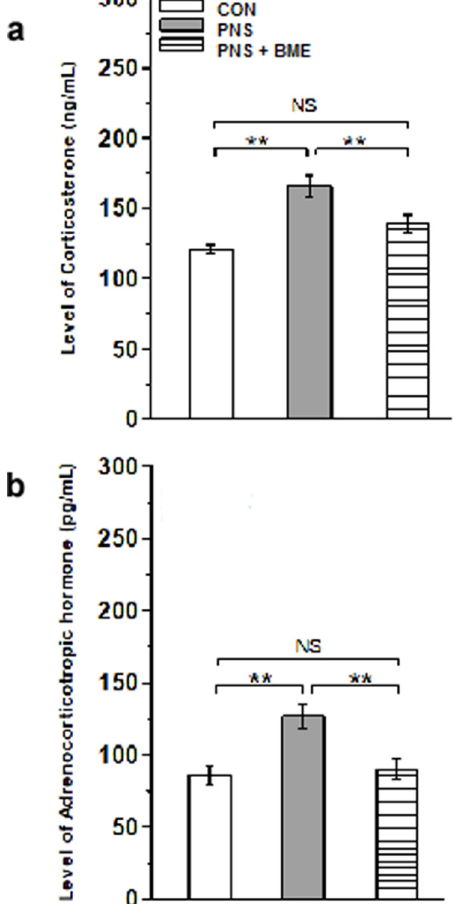
Figure 4. Maternal exposure to BME treatment and the resilience effect on the PNS-induced changes in offspring plasma. ( a ) Corticosterone (CORT); ( b ) Adrenocorticotropic hormone (ACTH) level. Exposure to BME treatment significantly reduced the PNS-induced CORT and ACTH level. Data are expressed as mean ± SEM ( n = 6 for each group). One-way ANOVA followed by Bonferroni post hoc test (for all pairwise multiple comparisons, statistical significance is indicated by ** p < 0.01; NS—Not significant).